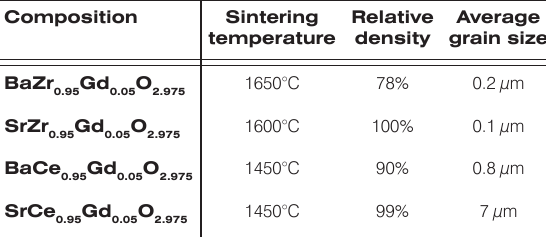
Relative Average density grain